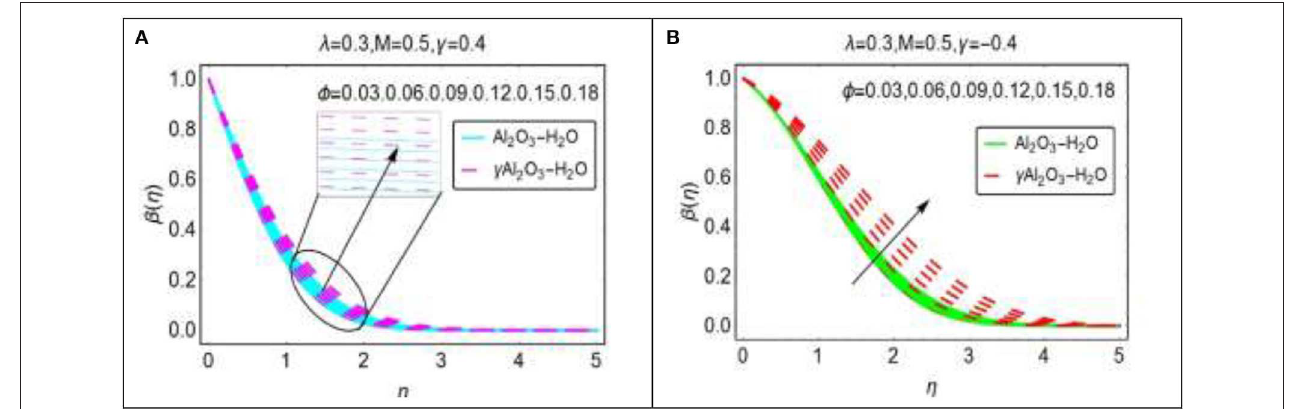
FIGURE 8 | The effects of φ on dimensionless temperature β ( η ) for (A) γ = 0.4, (B) γ = − 0.4.